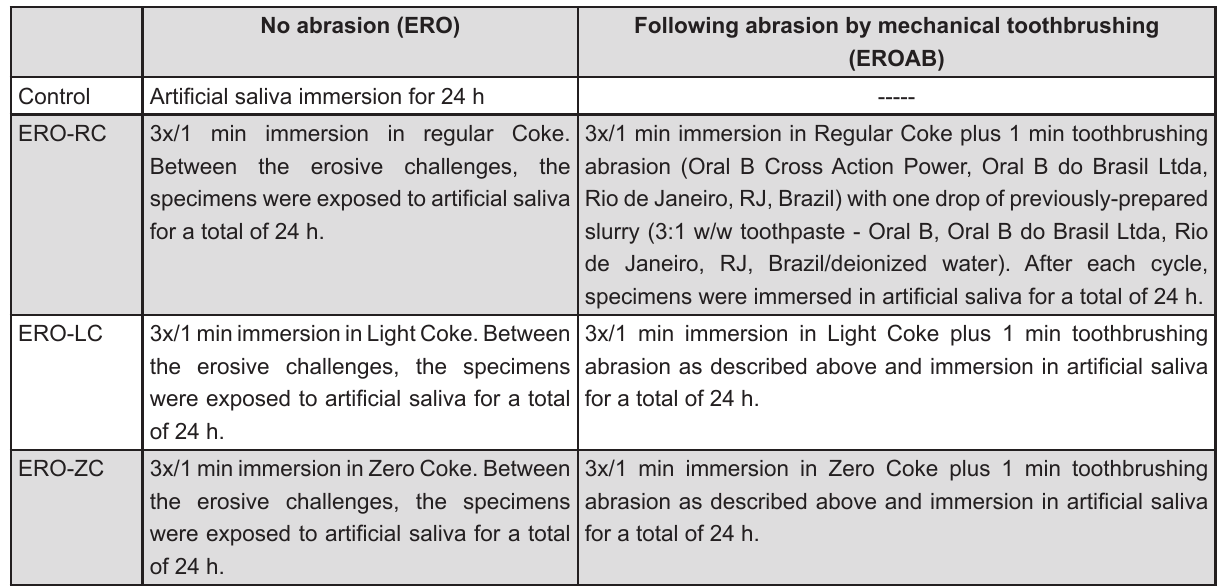
Figure 2- Groups tested according to erosive/abrasive